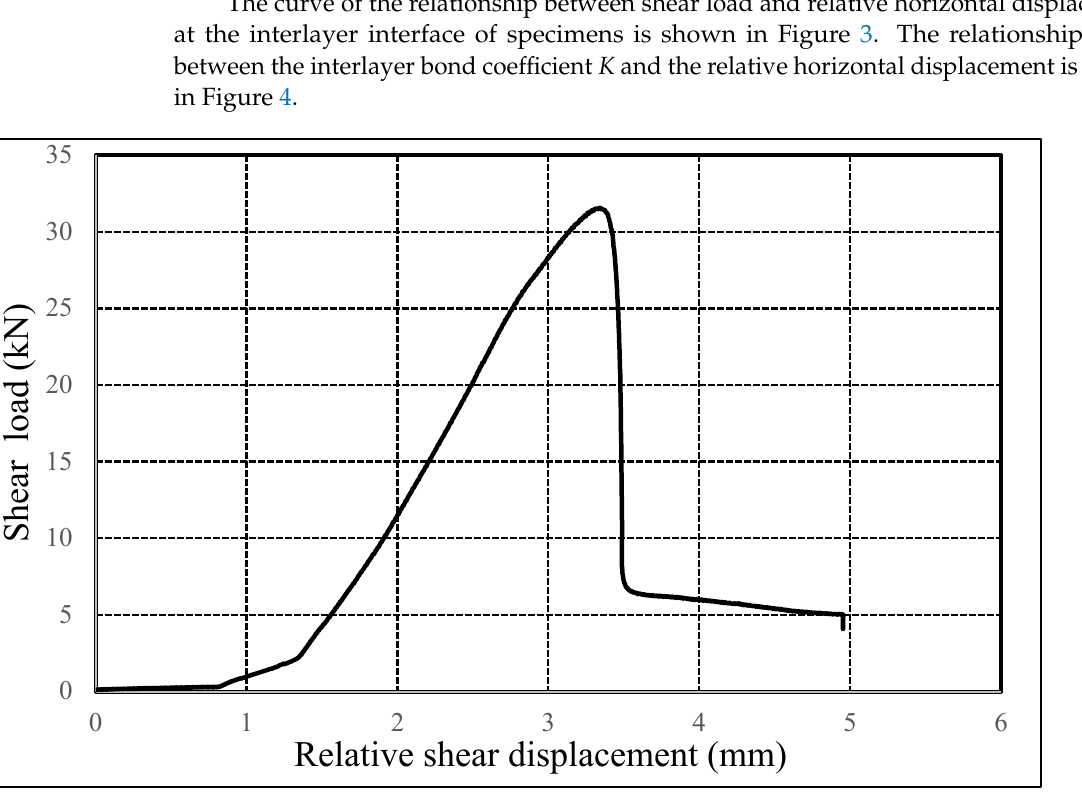
Figure 4. The relationship between interlayer bonding coefficient and relative shear displacement.